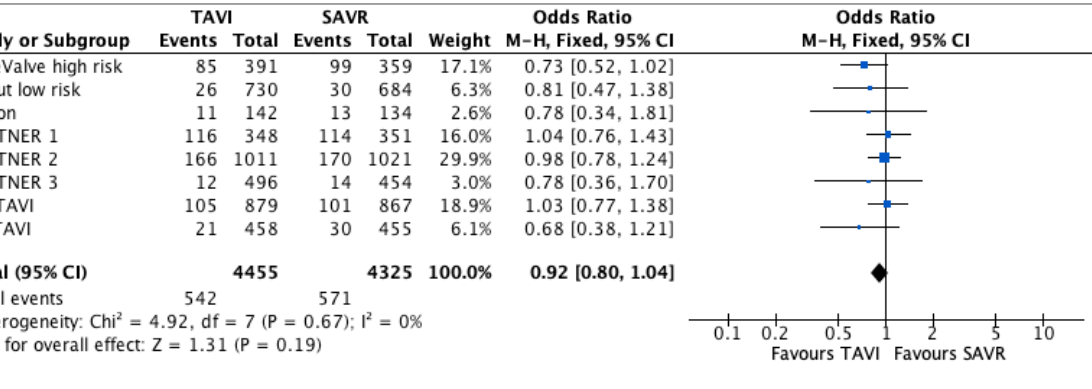
Figure 2. Forest plots for all-cause mortality.